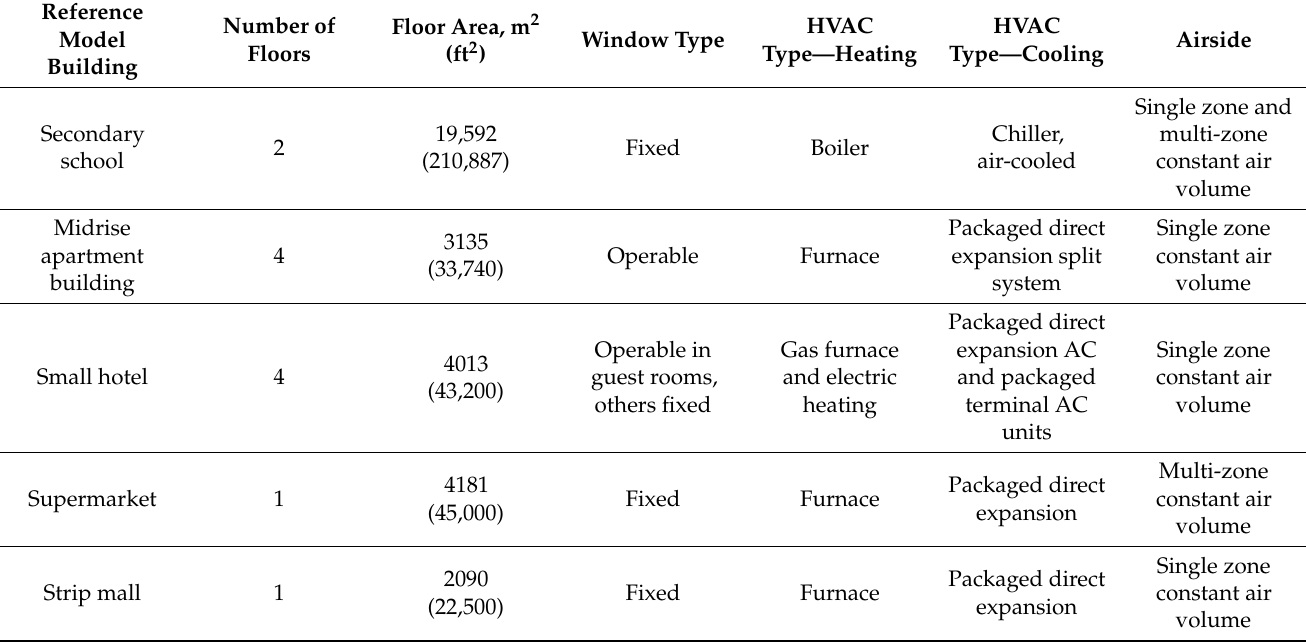
Table 4. Reference model buildings and details (from Field et al.